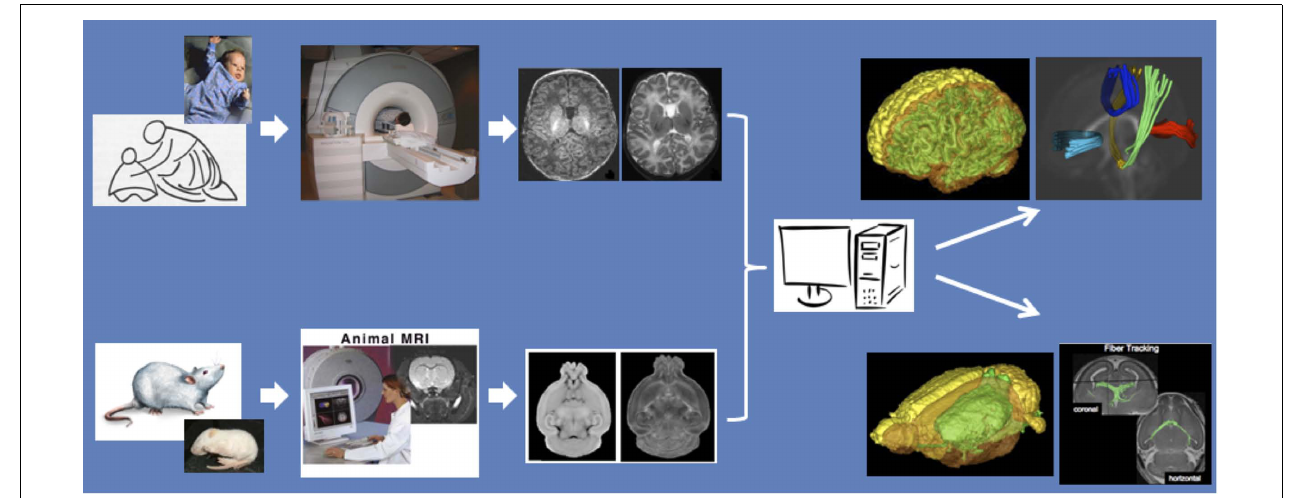
FIGURE 1 | Mother and infant neuroimaging of humans and animals using dedicated scanners, and comparable imaging sequences and image processing methods for inter-species studies.